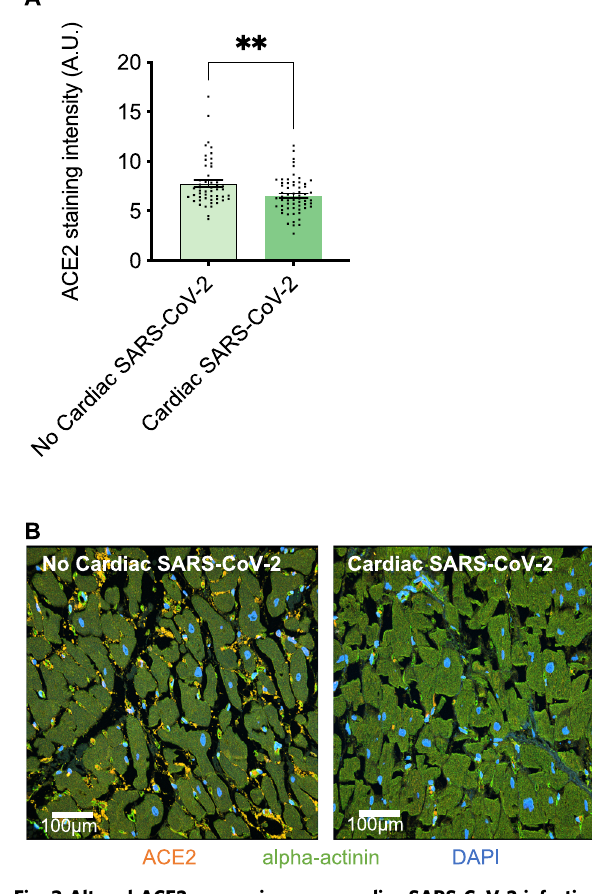
Fig. 3 Altered ACE2 expression upon cardiac SARS-CoV-2 infection. A Cardiac ACE2 staining intensity was signi fi cantly downregulated in hearts with cardiac SARS-CoV-2 viral load ( p = 0.003, Unpaired t-test, n = 5 high- power fi elds per section). B Representative immuno fl uorescence images of ACE2 and alpha-actinin stained tissue sections from hearts without and with cardiac SARS-CoV-2